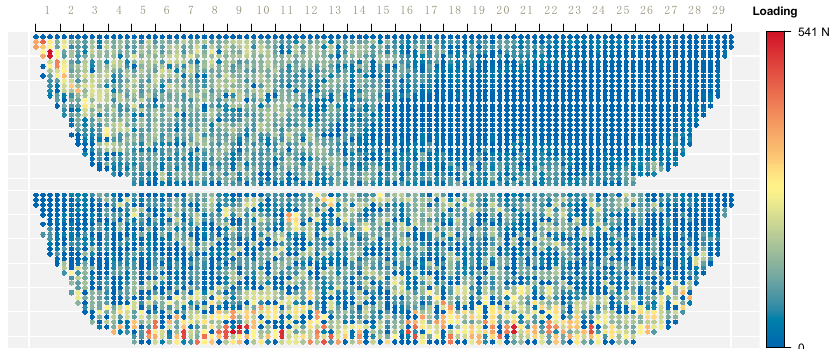
Figure 6. Load distribution at the knots of unfolded seine net made up of 29 strips, at the end of shooting (top) and during pursing (bottom). The averaged breaking strength of strands was measured to be ca. 1700 N.